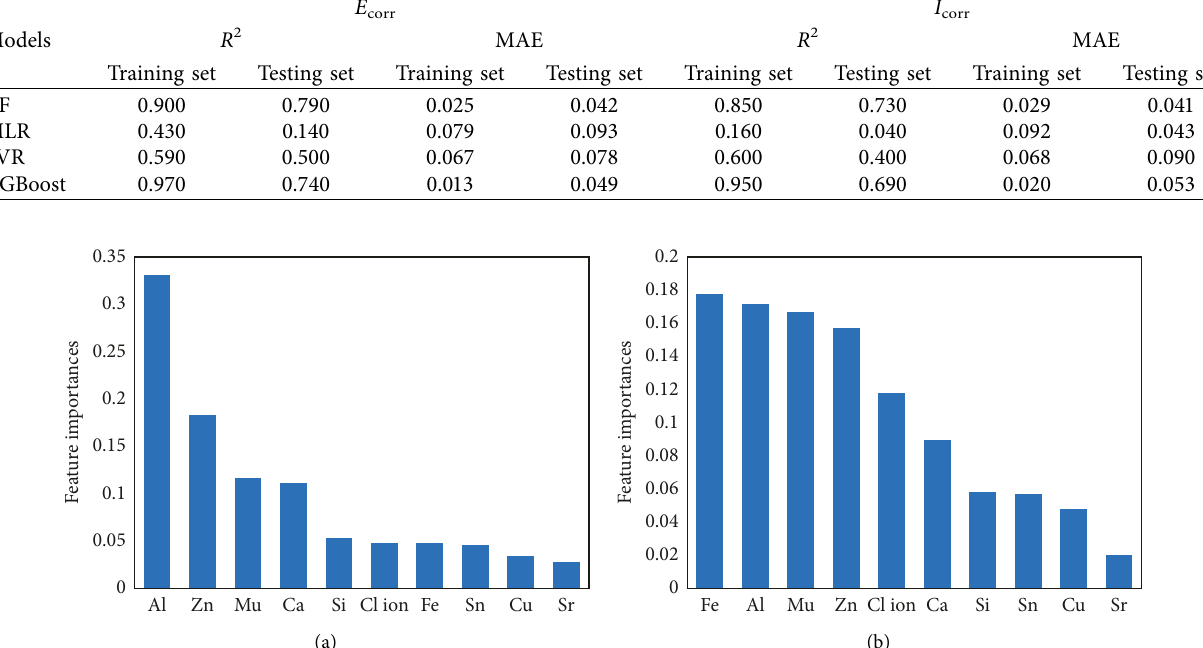
Figure 2: Importance of the input characteristics corresponding to (a) corrosion potential and (b) corrosion current prediction